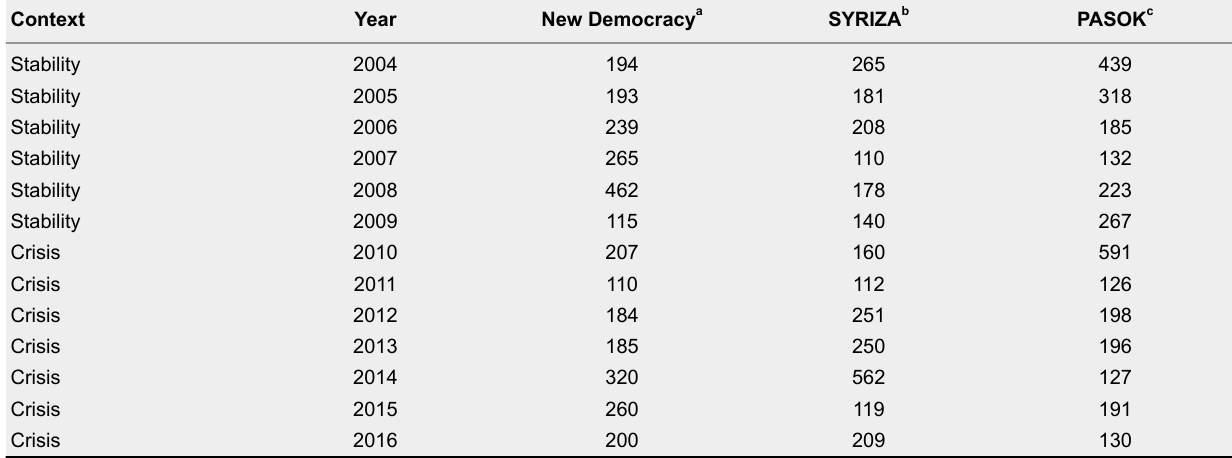
Number of Words per Political Speech, Party, and